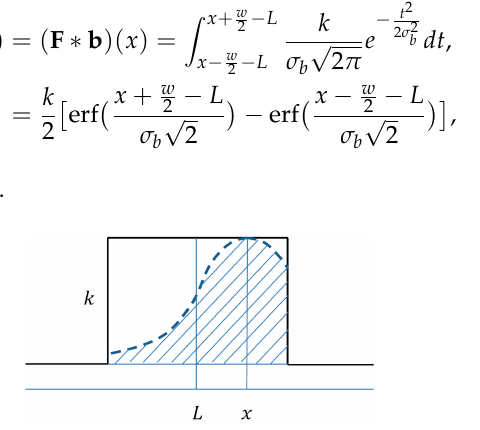
Figure 2. Gaussian blur for one-dimensional line model.